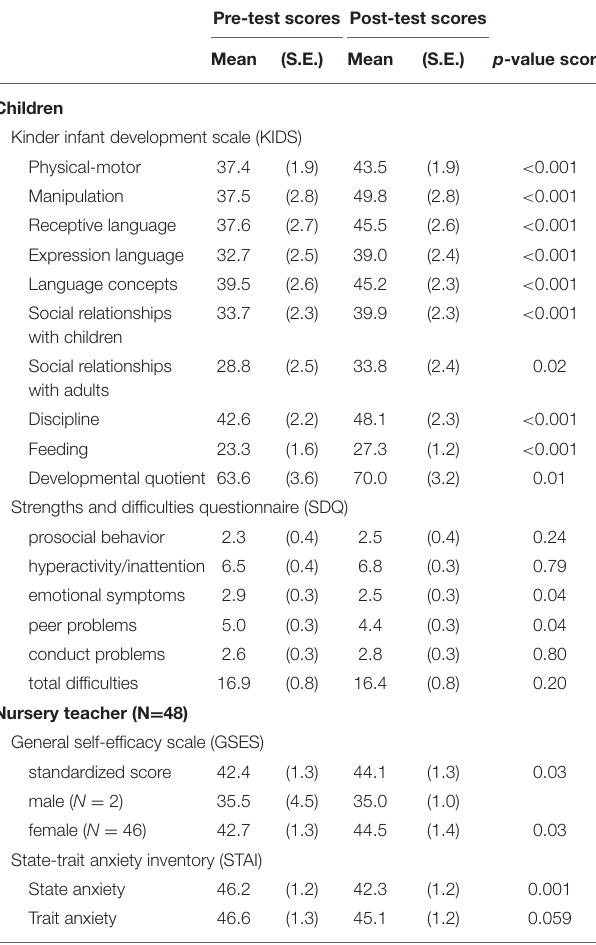
GSES and STAI. Pre-test scores Post-test scores Mean (S.E.) Mean (S.E.)